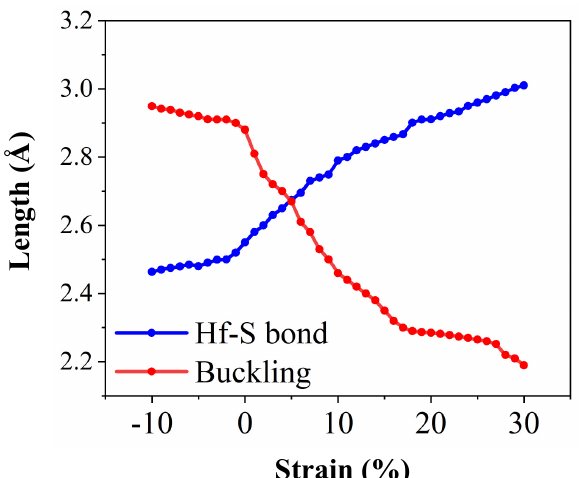
Figure 10. Hf-S bond length and buckling of the HfS 2 monolayer under D 3 deformation in the range of − 10% to 30% straining.